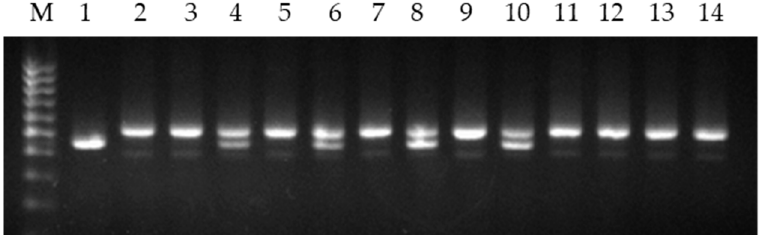
repeat. M: 100 bp ladder marker; 1: L-319; 2: Om29; 3: Sar29; 4: L-15(1); 5: L-15(2); 6: L-23(1); 7: L-